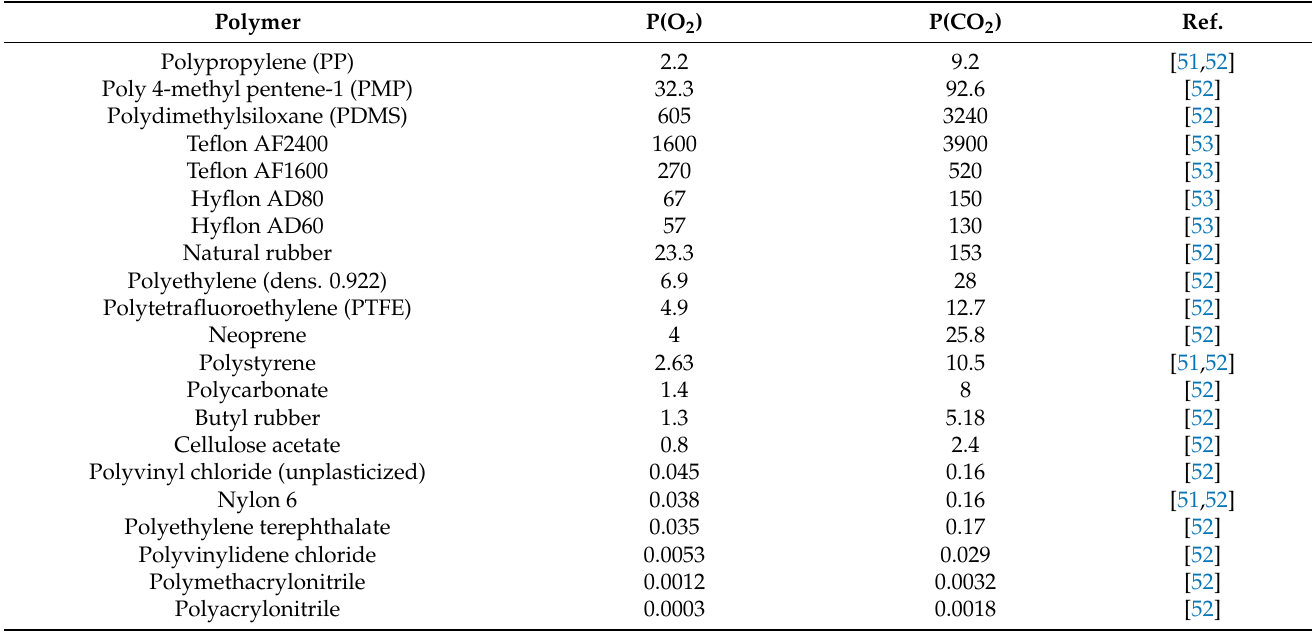
Table 4. The intrinsic gas permeability (barrer) of oxygen and carbon dioxide at 30 ◦ C for dense polymeric films. Polymer P(O 2 ) P(CO 2 ) Ref.